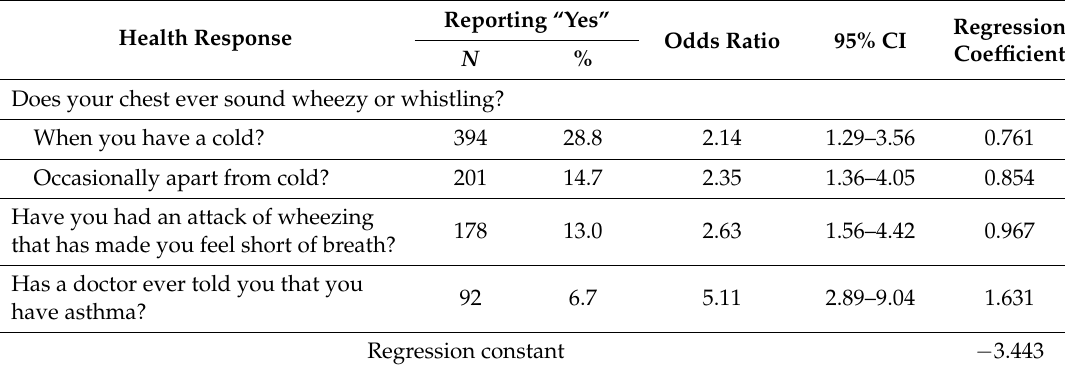
Table 3. Prediction of asthma diagnosis in physician administrative data from self-reported ill-health in the linked sample ( N =